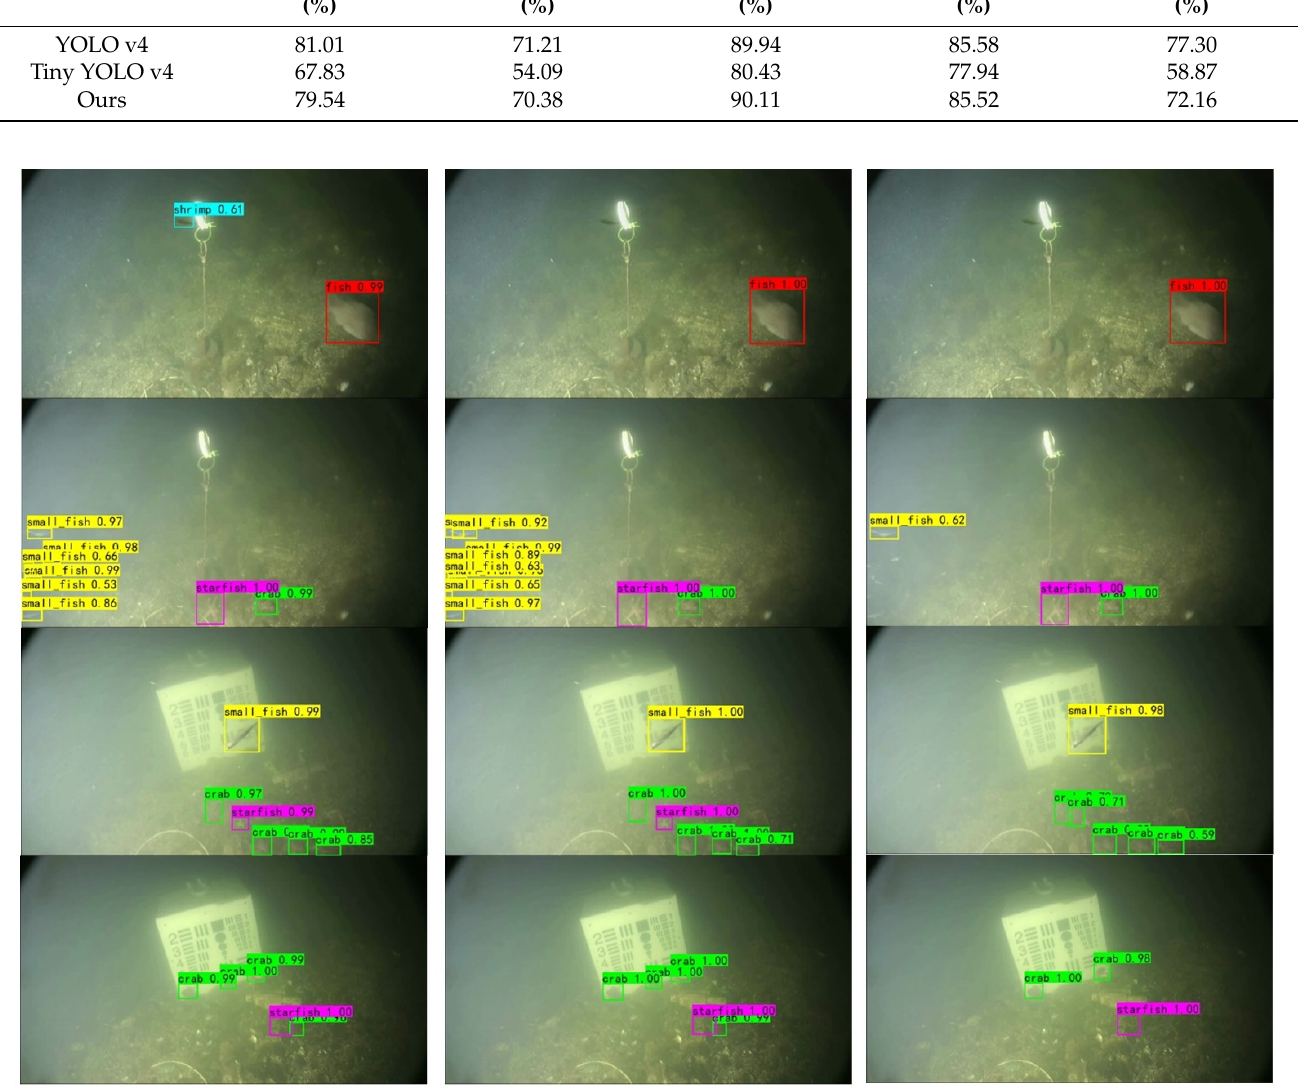
Figure 10. Visualization detection results for the brackish underwater dataset compared with YOLO v4 and Tiny YOLO v4.